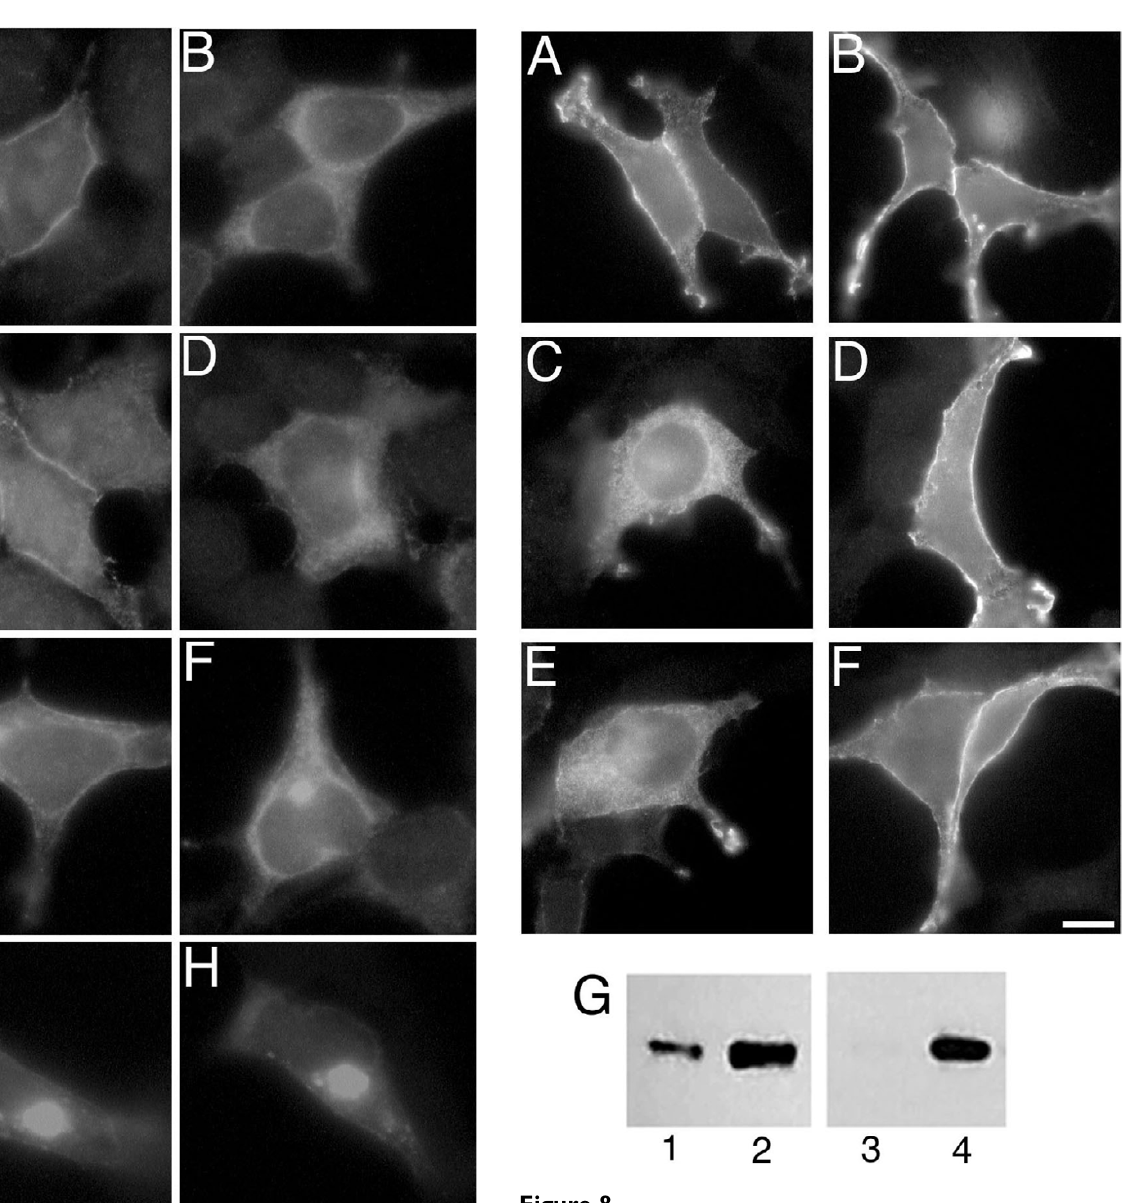
Figure 8 Localization of α , s α , and α A327S and the effect i2 i2 i2 of βγ Expression vectors encoding α i2 (A and B), s α i2 (C and D), or α i2 A327 (E and F) were transfected alone (A, C, and E) or together with expression vectors for β 1 and γ 2 (B, D, and F) into BHK cells. Proteins were visualized by immun- ofluorescence microscopy using the EE monoclonal antibody followed by an Alexa 488 conjugate anti-mouse antibody. Bar, 10 µ m. G , EE- α i2 -pcDNA3 (lanes 1 and 2) or EE-s α i2 - pcDNA3 (lanes 3 and 4) were transfected into COS-7 cells alone (lanes 1 and 3) or with co-transfection of vectors encoding β 1 and γ 2 (lanes 2 and 4). Immunoblotting with the EE antibody detected α i2 or s α i2 . Note that s α i2 expressed alone (lane 3) is very weakly detected and barely visible in this total cell